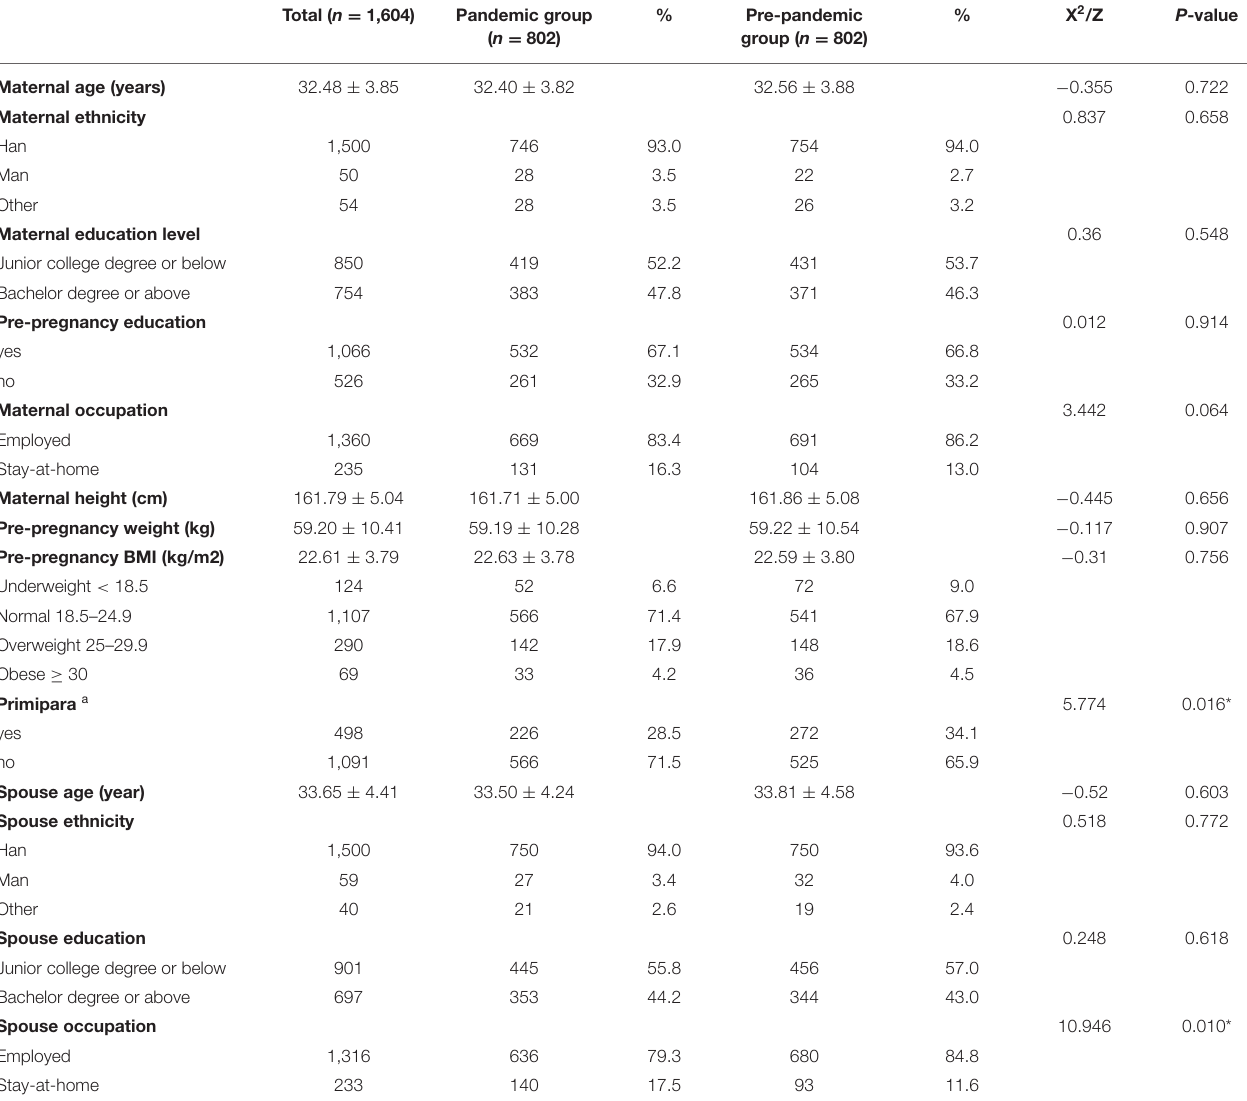
TABLE 1 | Characteristics of 1,604 pregnant women before and during the COVID-19 pandemic, China, 2018-2020. Total ( n = 1,604) Pandemic group % Pre-pandemic % X 2 /Z P ( n = 802) group ( n = 802)